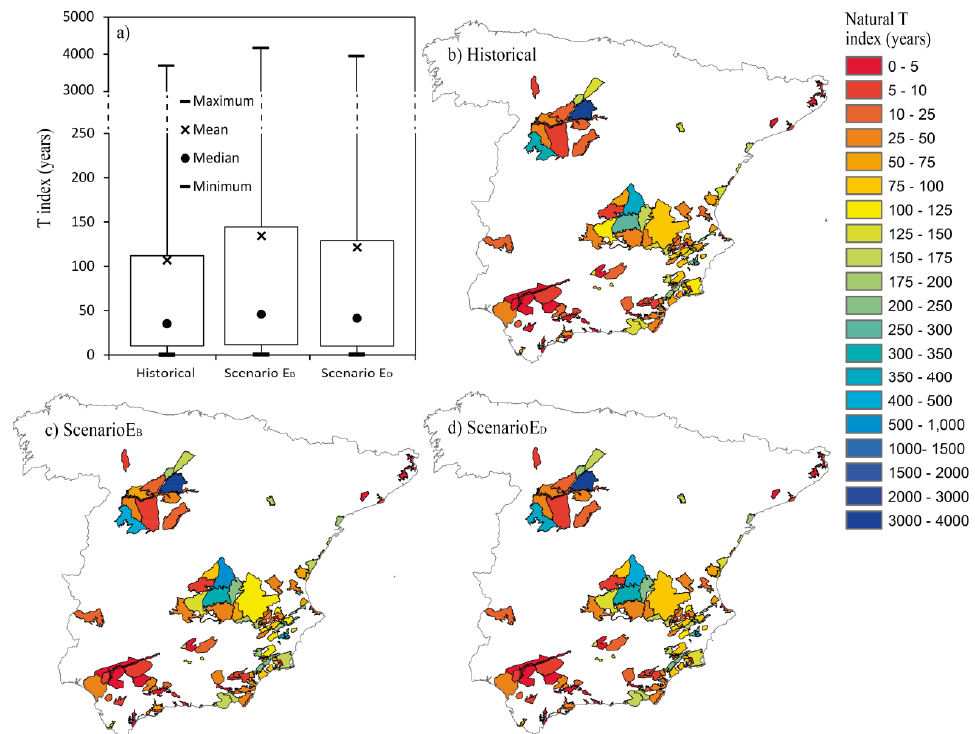
Figure 7. Box-whiskers ( a ) and maps of the T index in the 146 Spanish GW bodies at risk [1]. Historical ( b ) values and future potential scenarios (EB ( c ) and ED ( d ) in the horizon 2011–2045. The differences between the future scenarios (E B and E D ) in terms of impacts on the T index are small, due to the differences between the impacts on mean R also being small (see maps of Figure 6). The mean values of R for both scenarios are very similar, although the monthly series are different (see temporal series of Figure 6).